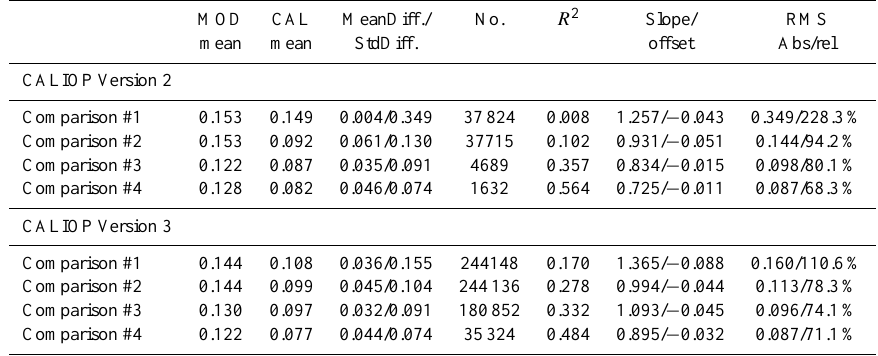
Table 6. MODIS vs. CALIOP AOD532, January 2009, over-ocean. MOD CAL